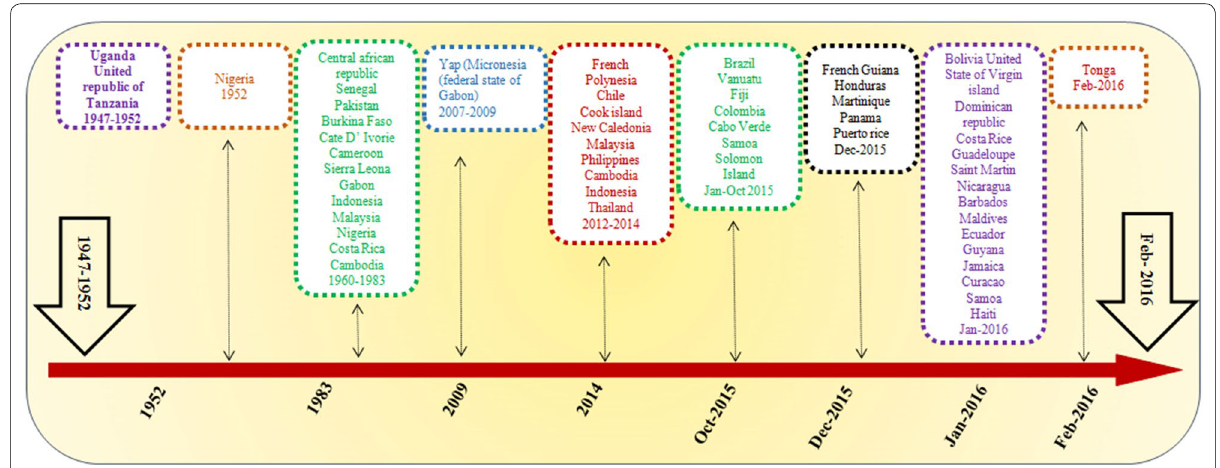
Fig. 1 Chronological time-line of ZIKV epidemic from